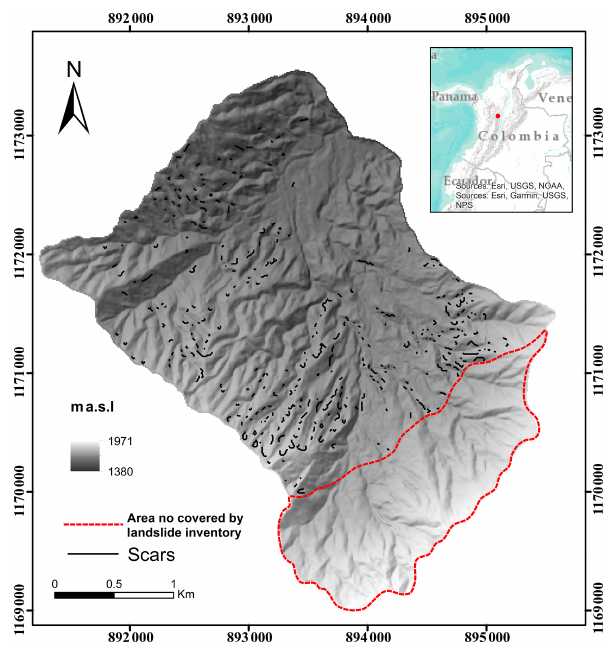
Figure 1. Landslides scars inventory database according to land- slide inventory. The area with a red line does not have a landslide inventory. Source: adapted from INTEGRAL (1990) and Velásquez and Mejía (1991).